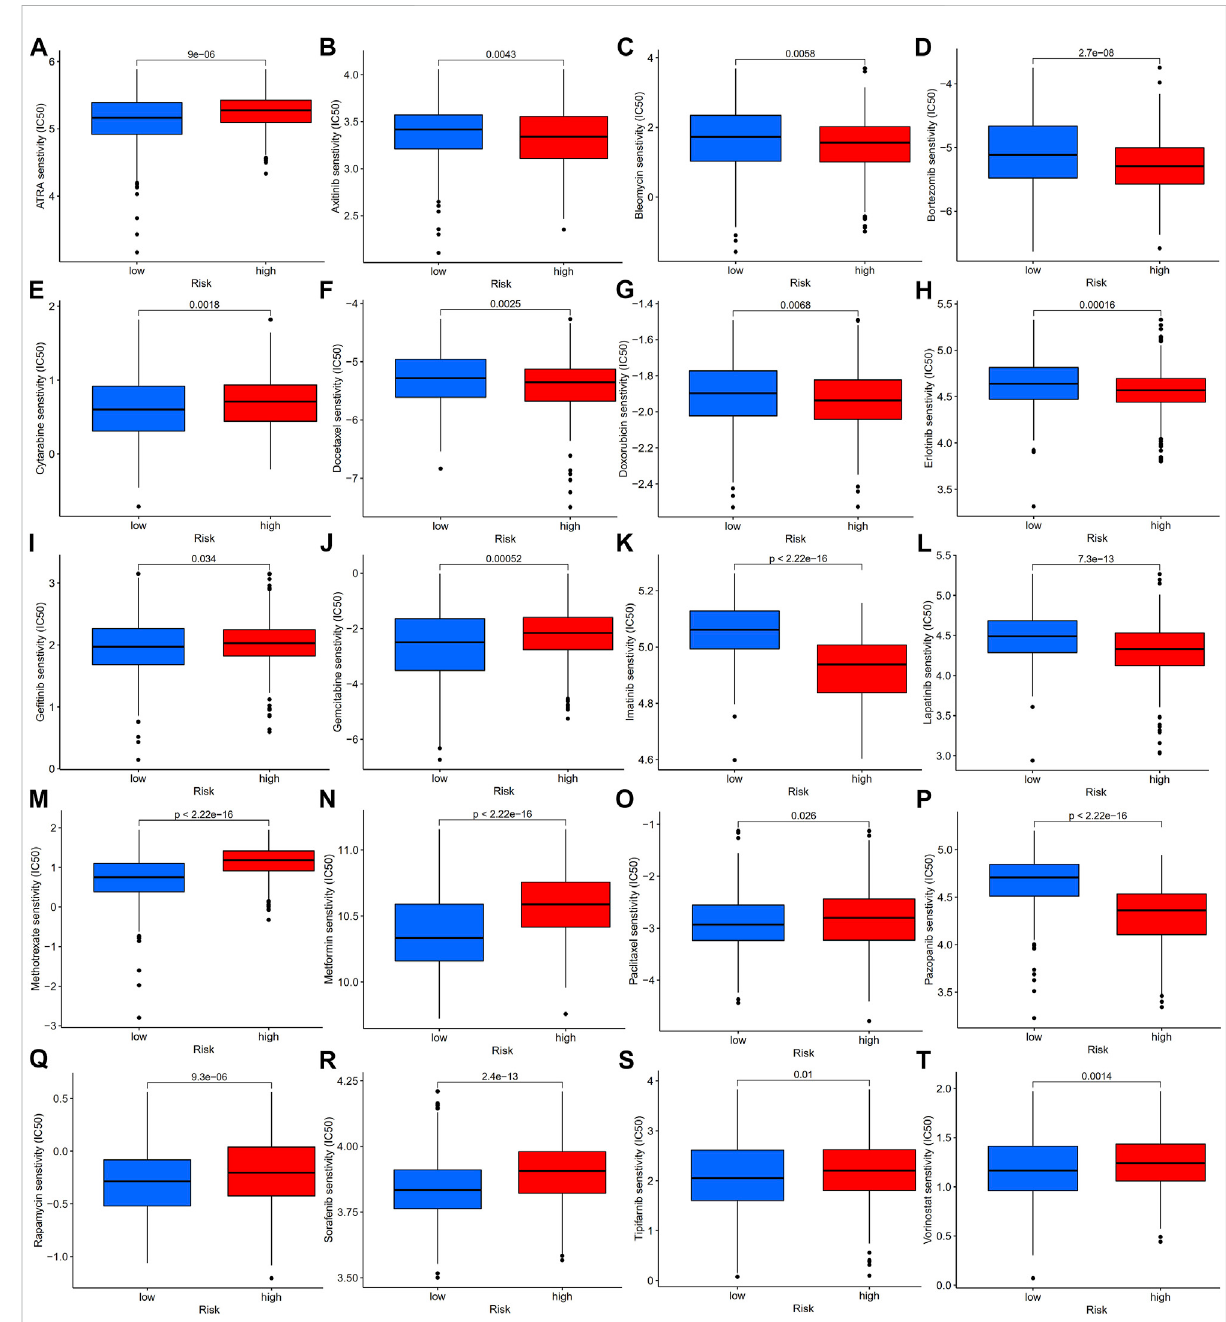
FIGURE 12 Antitumor drug sensitivity analysis of gastric patients in high- and low-risk groups, IC50 analysis of ATRA (A) , axitinib (B) , bleomycin (C) , bortezomib (D) , cytarabine (E) , docetaxel (F) , doxorubicin (G) , erlotinib (H) , ge fi tinib (I) , gemcitabine (J) , imatinib (K) , lapatinib (L) , methotrexate (M) , metformin (N) , paclitaxel (O) , pazopanib (P) , rapamycin (Q) , sorafenib (R) , tipifarnib (S) , and vorinostat (T) in the high- and low-risk groups, which were classi fi ed by the prognostic model. IC50, half-maximal inhibitory